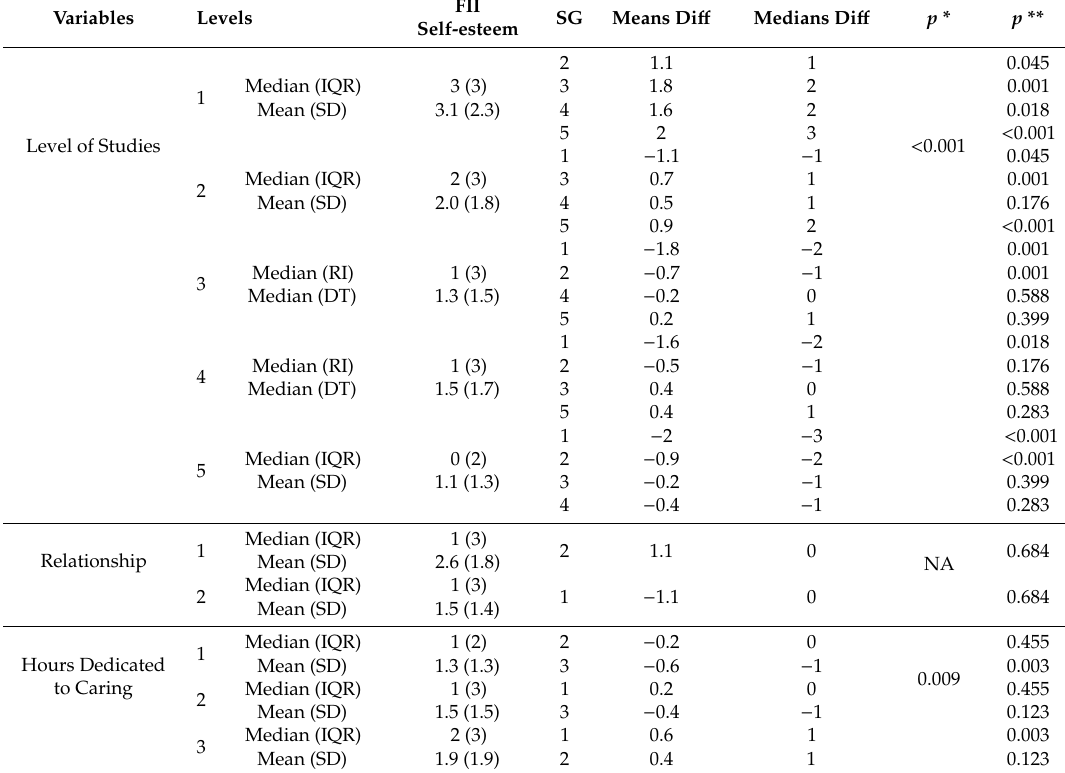
Table 4. Comparison of Factor II “Self-esteem” according to the level of studies, relationship and hours dedicated to caring.